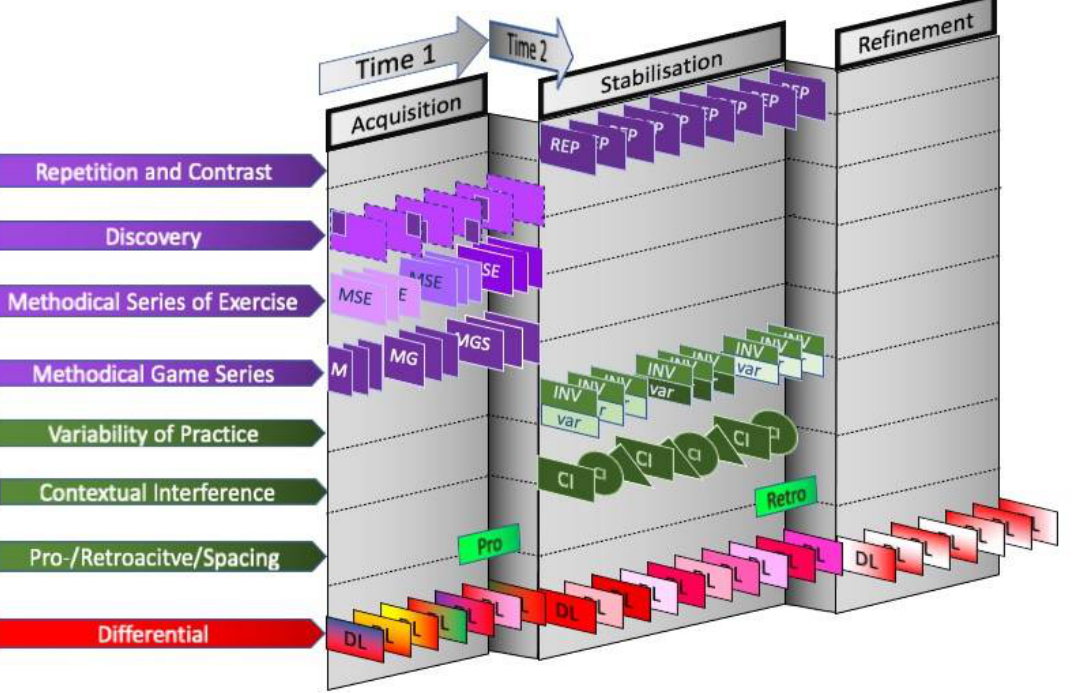
Figure 2. The motor learning models structured by their time-scale-dependent area of application according to their original model claims.